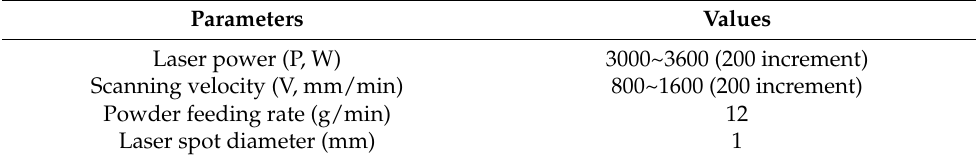
Table 3. Processing parameters for the single